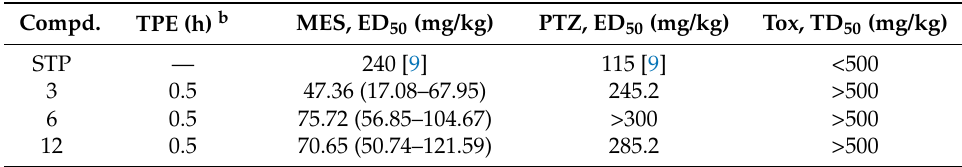
Table 3. Quantitative Anticonvulsant Data in Mice ip a (ED 50 , TD 50